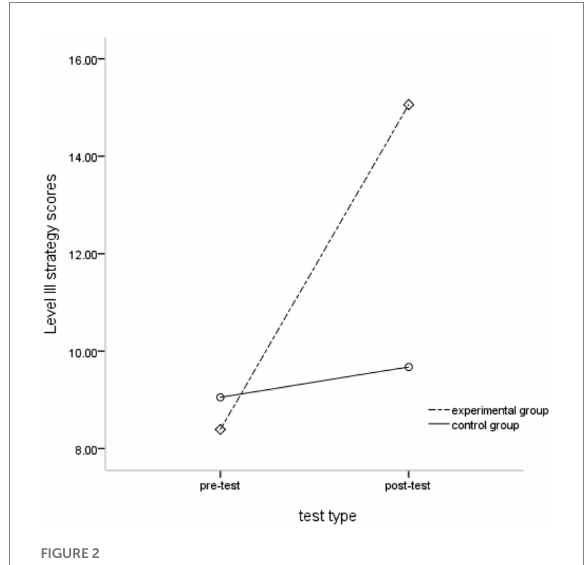
FIGURE 2 Comparison of Level III strategy scores between the experimental group and the control